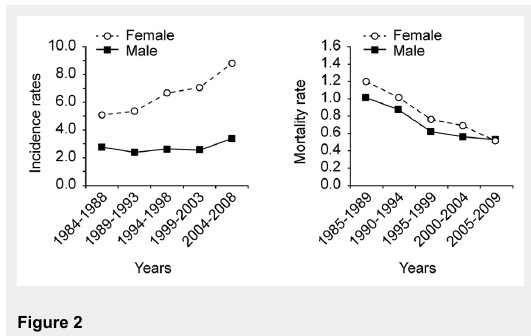
Figure 2 Incidence and mortality rate of thyroid cancer in Switzerland. Adapted from the National Institute for Cancer Epidemiology and Registration,